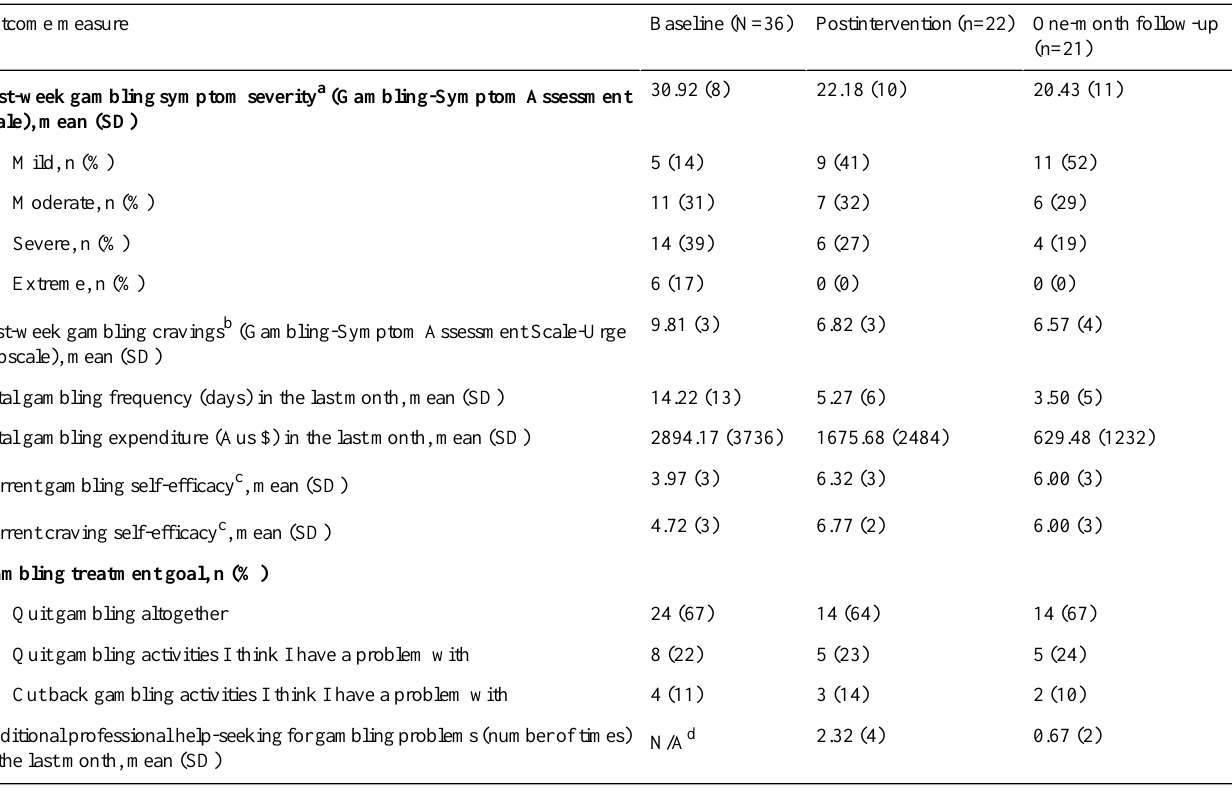
Table 5. Descriptive statistics (mean and SD) for measures administered at baseline, postintervention, and 1-month follow-up